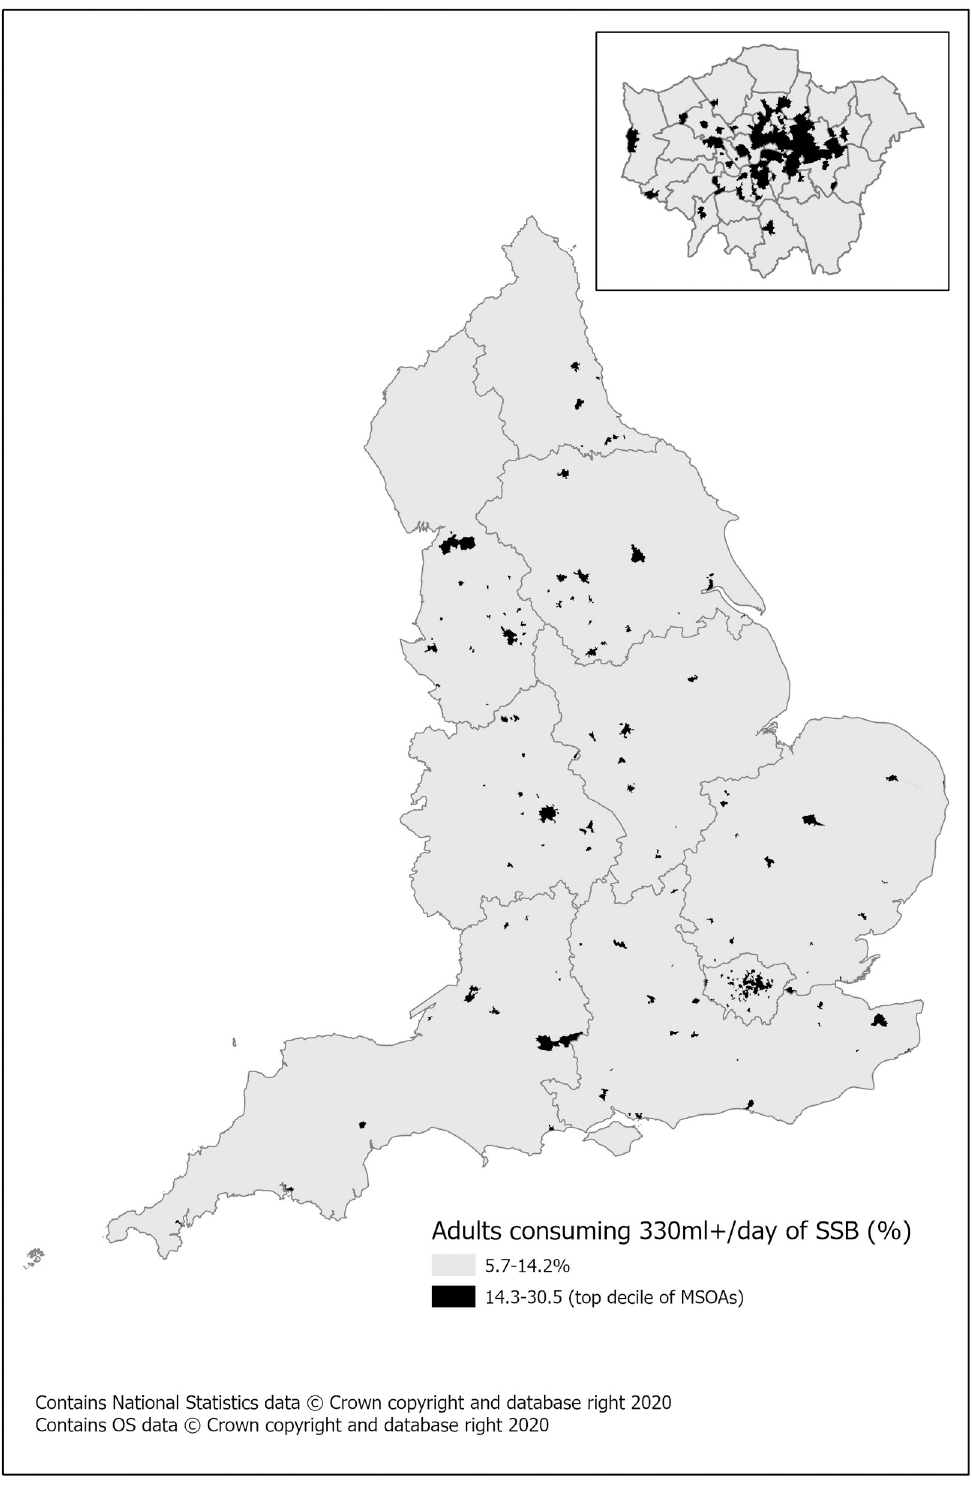
Fig 2. Estimated prevalence consuming more than 330ml SSB per day. This represents prevalence in adults by MSOA (2018 population) with inset of London.